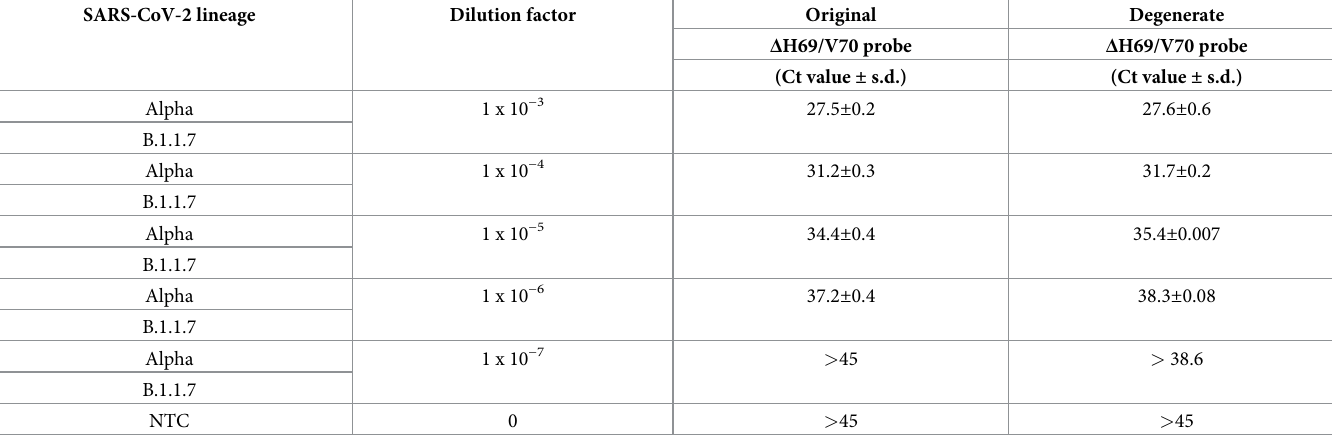
Table 2. Threshold values (Ct) reported for the TWIST synthetic SARS-CoV-2 RNA quality control assayed with the original and degenerate Δ H69/70 probe in RT- qPCR. SARS-CoV-2